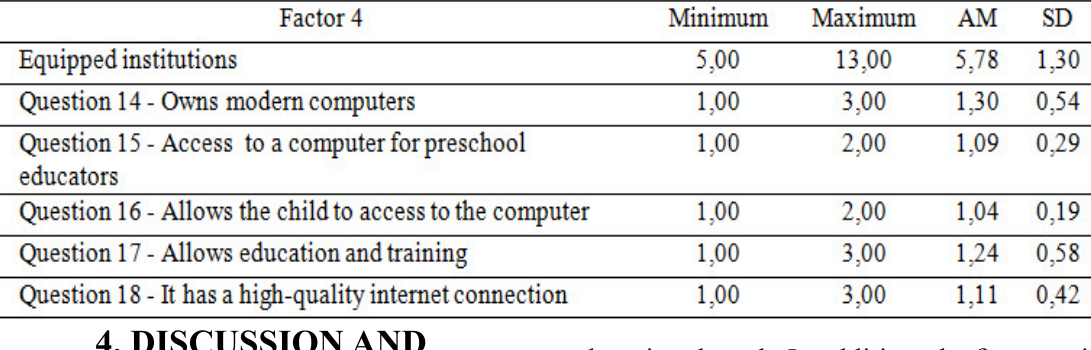
Table 8. Expressiveness of attitude on the equipment of the institution where the pre- school